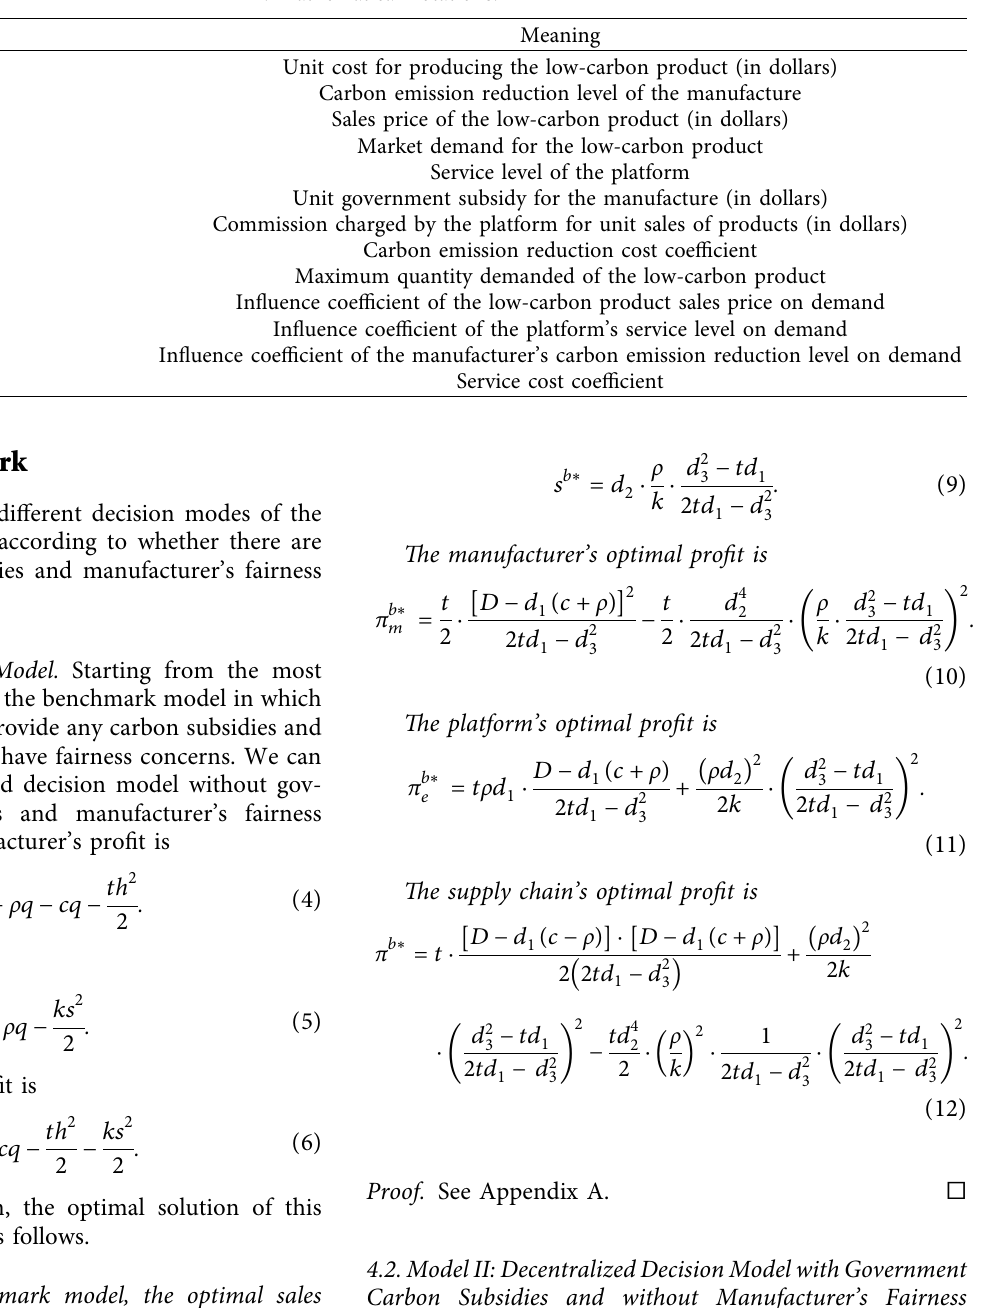
Table 1: Mathematical